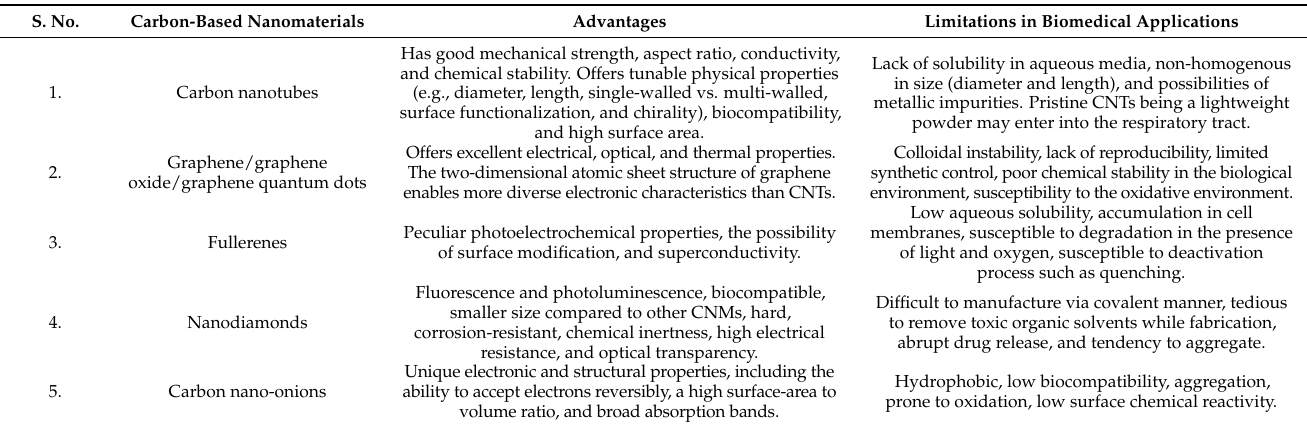
Table 1. A brief overview of carbon nano-onions (CNMs) with their advantages and limitations